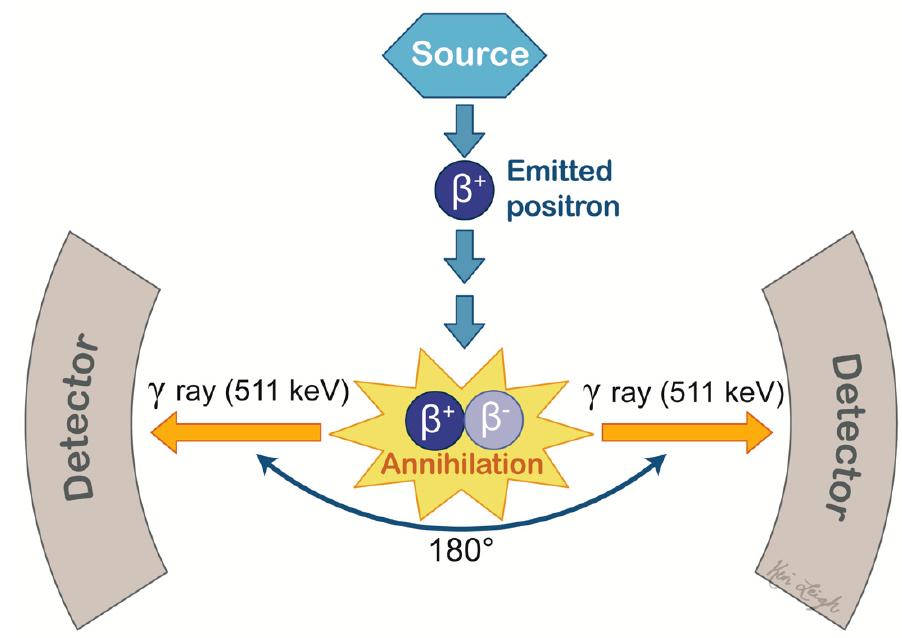
Figure 6. Positron emission tomography scan mechanism. Decay occurs by the conversion of a proton into a neutron with positron emission. When the emitted positron unites with a nearby electron in an annihilation event, a pair of two photons ( γ -rays) at 511 keV are produced, each traveling in opposite directions. The γ -rays are detected by sensors on the PET scanner. When both photons are detected in one coincidental event, an image is produced and is assumed to have occurred along the line of response.